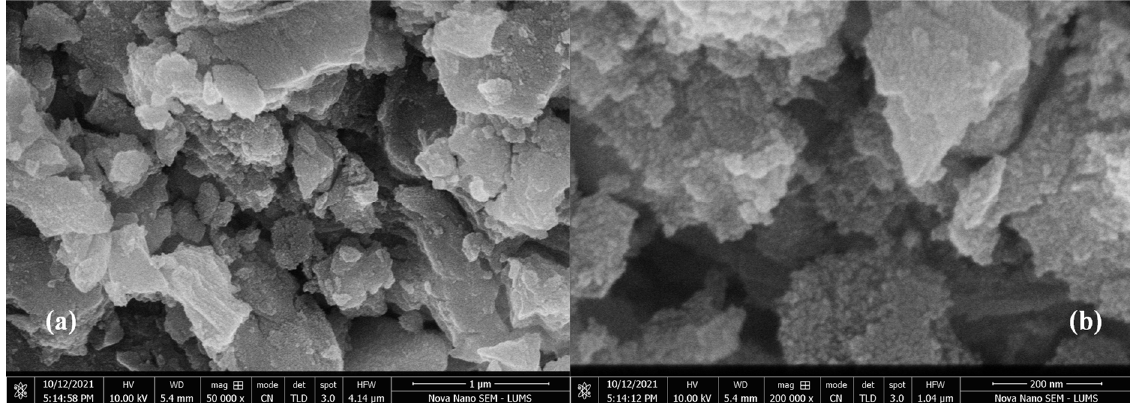
Figure 4. SEM micrographs of Fe NPs at 1 µm ( a ), 200 nm ( b ).